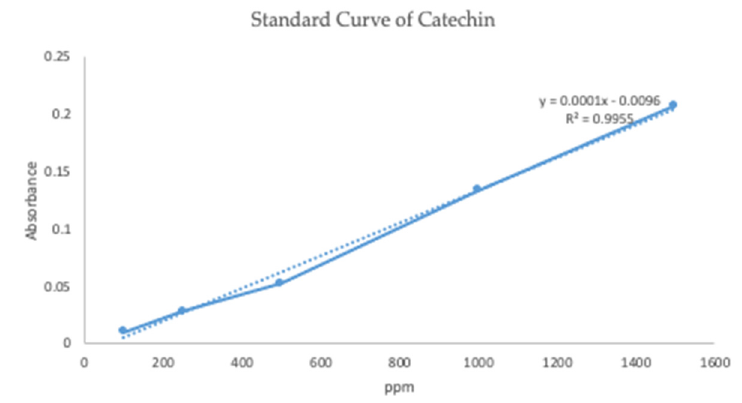
Figure 4. Standard curve of catechin.